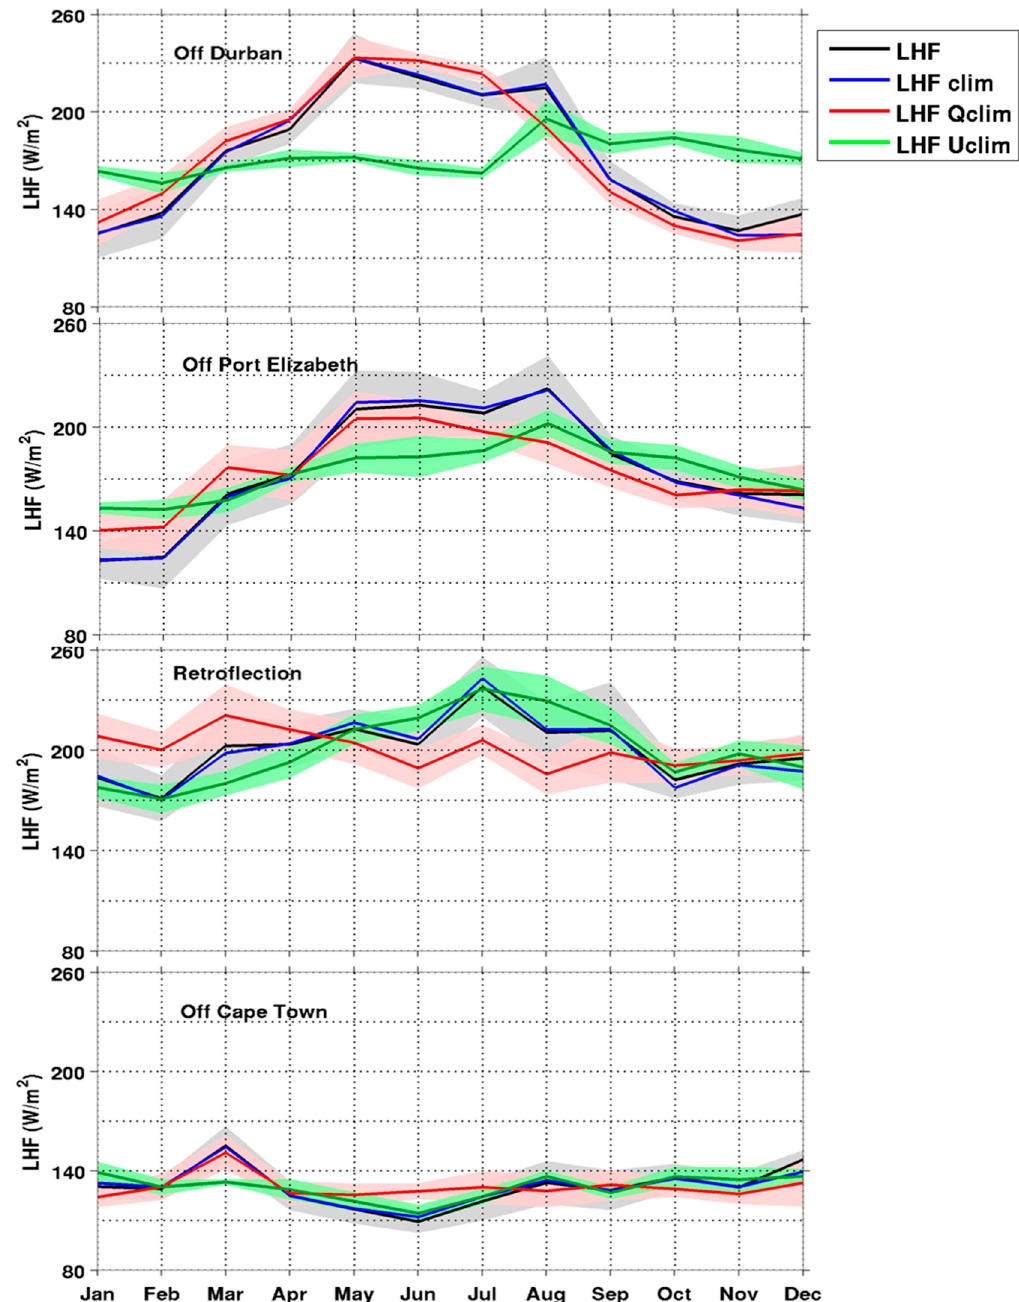
Figure 16 : SEAFLUX annual cycles of latent heat flux (W/m²) (black) and the recalculated latent heat flux using: a monthly climatology wind speed and Qss-Qa (LHF_clim, blue); a monthly climatology of Qss-Qa and the annual mean of wind speed (LHF_Qclim, red), and a monthly climatology of wind speed and the annual mean of Qss-Qa (LHF_Uclim, green) off Durban, off Port Elizabeth, Retroflection region, and off Cape Town. Shade areas represent the standard errors.